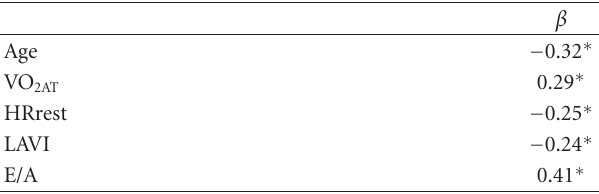
Table 6: Multi-variate regression analysis for Mean